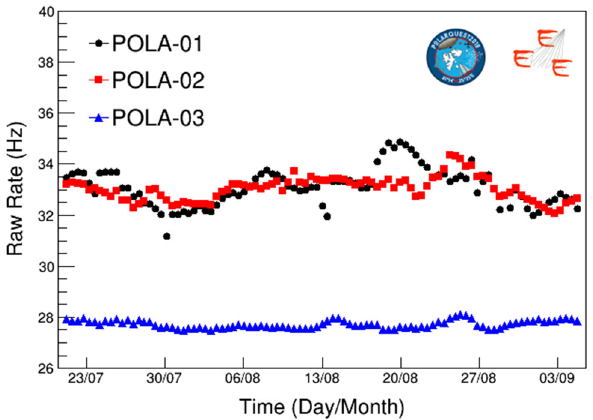
Fig. 15 Raw rate measured by POLA-01 (black circles), POLA-02 (blue squares) and POLA-03 (blue triangles) as a function of the time since July 22, 2018 till September 4, 2018